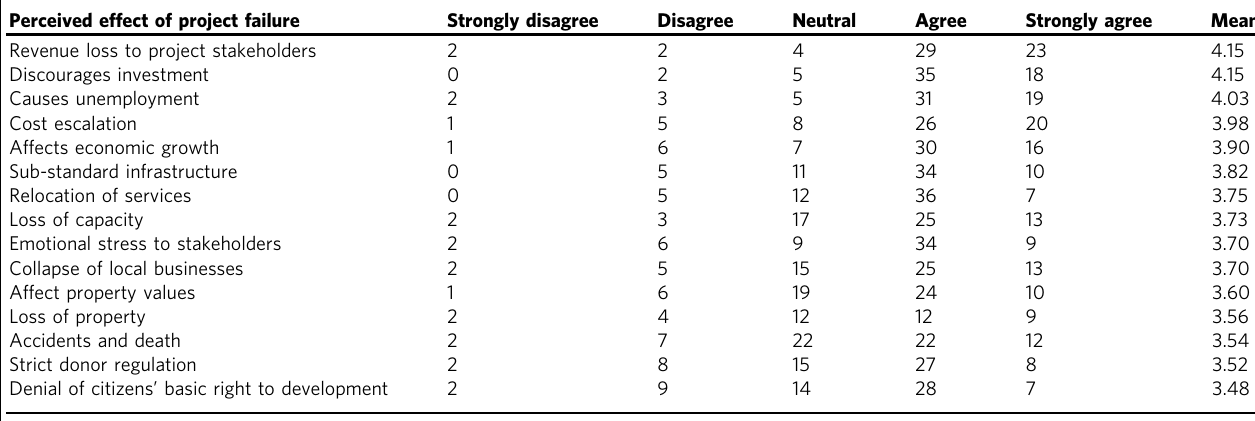
Table 7 Perceived effects of public project failure ( N =